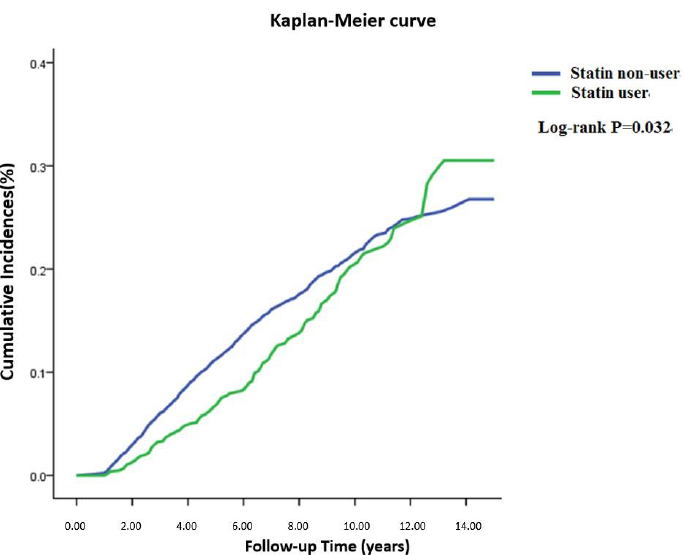
Figure 2. Cumulative incidence of diabetes mellitus by statin use among TIA patients in Taiwan during follow-up time. Table 3. Time-dependent covariate Cox model for the effects of statin on first-time diabetes mellitus among transient ischemic attack